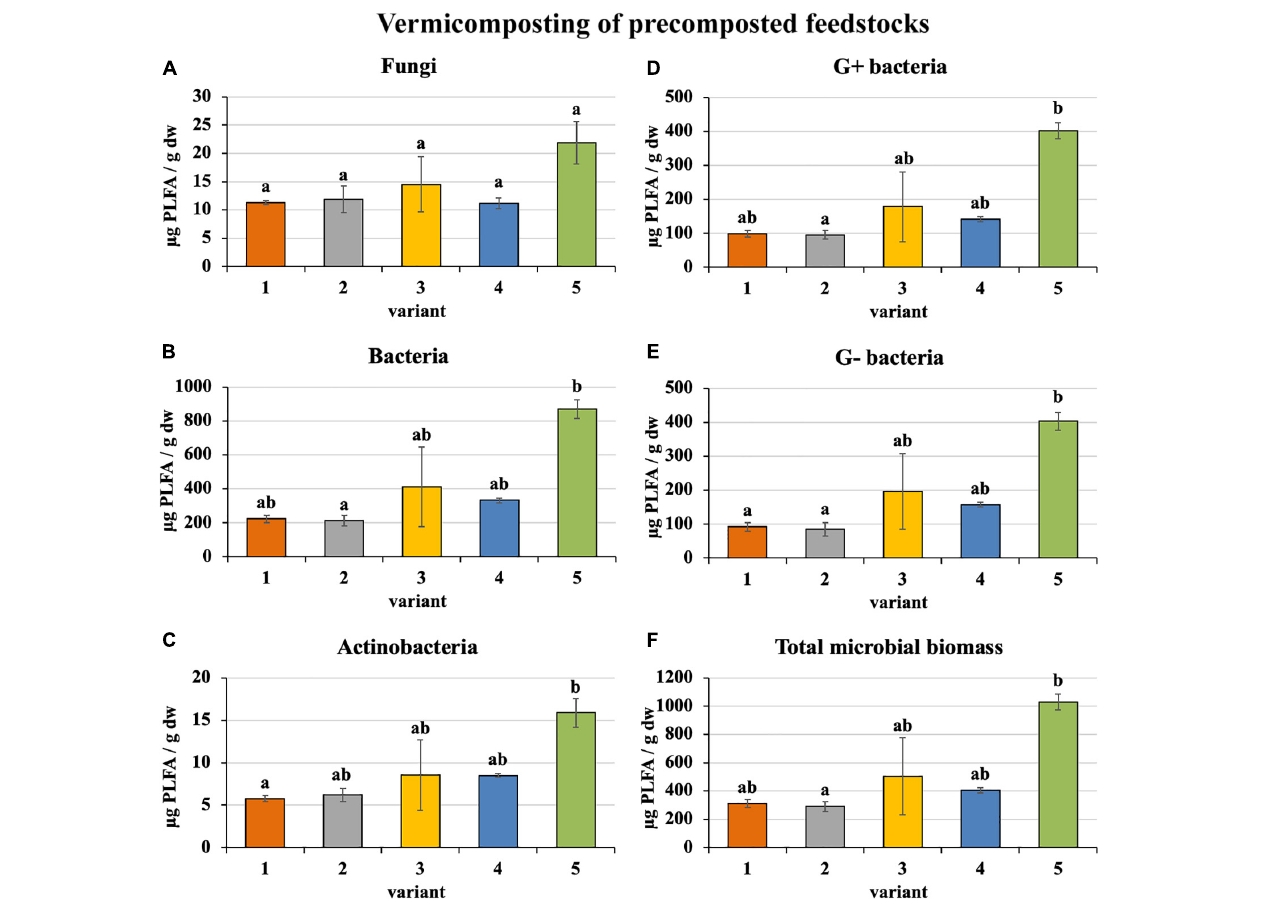
FIGURE 5 | Content of microorganisms after vermicomposting precomposted feedstock. Treatments: (1) sludge 100% with earthworms, (2) sludge 75% + PWS 25% with earthworms, (3) sludge 50% + PWS 50% with earthworms, (4) sludge 25% + PWS 75% with earthworms, and (5) PWS 100% with earthworms. Values are means ± SD ( n = 3). Different letters indicate significant differences among treatments (Kruskal–Wallis test, P ≤ 0.05). PWS, pelletized wheat straw; PLFA, phospholipid fatty acids; dw, dry